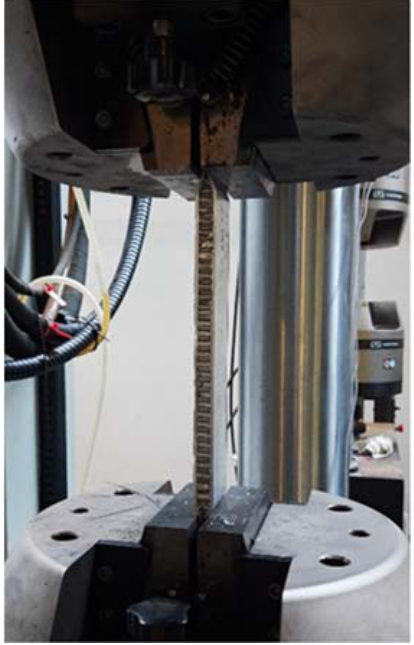
Figure 3. Experimental setup.